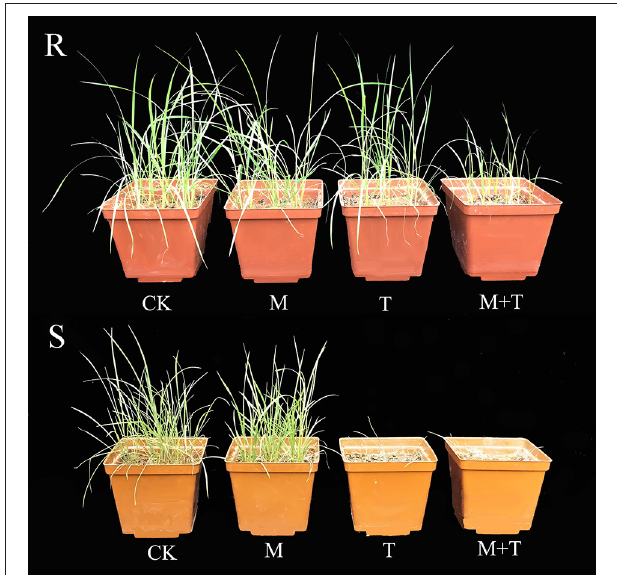
FIGURE 1 | Photographs of R (top) and S (bottom) Alopecurus aequalis plants 42 days after treatment, showing the untreated (CK), the malathion-only control (M; 1,000 g ai ha − 1 ), the mesosulfuron-methyl treatment (T; 9 g ai ha − 1 ), and the effects of the malathion plus mesosulfuron-methyl (M + T;